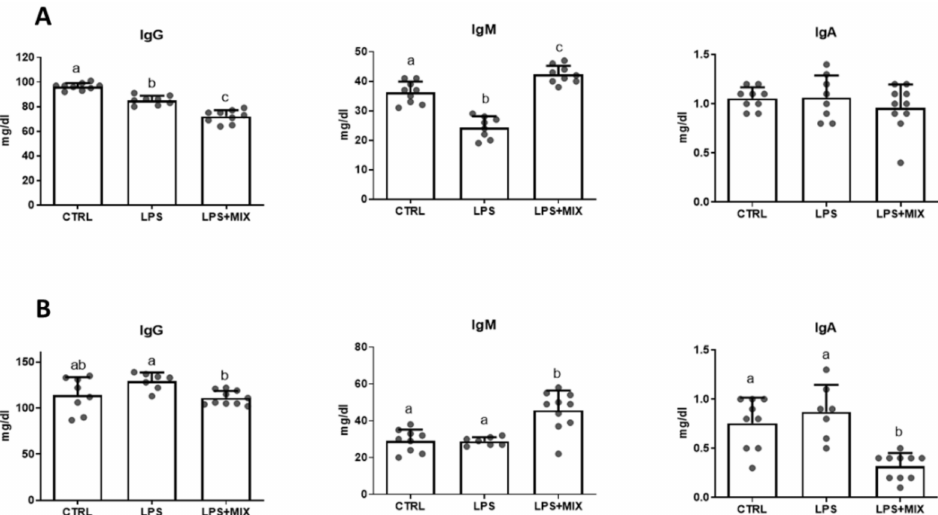
Figure 2. Serum concentrations of immunoglobulins IgG, IgM, and IgA on day 10 (( A )—upper panel) and day 35 (( B )—lower panel). Groups are: CTRL, the control group; LPS, the LPS-challenged group; LPS+MIX, the LPS-challenged supplemented with arginine, branched-chain amino acids (BCAA) and cystine mixture group. a,b,c: Histograms with different letters are significantly different ( p <